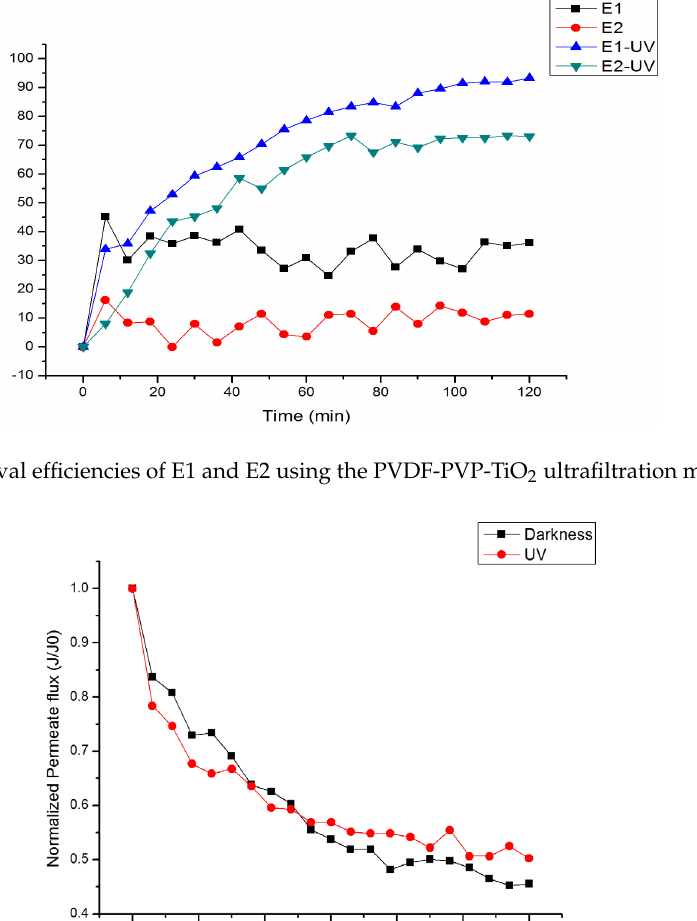
7 of 12 Figure 5. Removal efficiencies of E1 and E2 using a PVDF-PVP ultrafiltration membrane. 3.4. Removal Efficiencies of E1 and E2 Using the PVDF-PVP-TiO 2 Ultrafiltration Membrane Figure 6 shows the removal efficiencies of E1 and E2 by the PVDF-PVP-TiO 2 ultrafiltration membrane. The removal efficiencies of E1 and E2 were 36.1% and 11.4% at 120 min without UV photocatalysis which was better than that by the PVDF-PVP ultrafiltration membrane. At the same time, we found that the PVDF-PVP membrane had better removal efficiencies of E1 and E2 than the PVDF-PVP-TiO 2 membrane at the beginning of the reaction. It was caused by the nano-TiO 2 addition, which improved the membrane hydrophilic and anti-pollution capacity. Under UV photocatalysis, the removal efficiencies of E1 and E2 by the PVDF-PVP-TiO 2 ultrafiltration membrane were better than those by the PVDF-PVP membrane with UV photolysis. The removal of E1 and E2 onto the PVDF-PVP-TiO 2 membrane all reached equilibrium at approximately 90 min, and the removal efficiency was approximately 93.4% and 73.1%, respectively. For both estrogens, 50% quantities were removed by photocatalysis within 30 min. The result showed that the